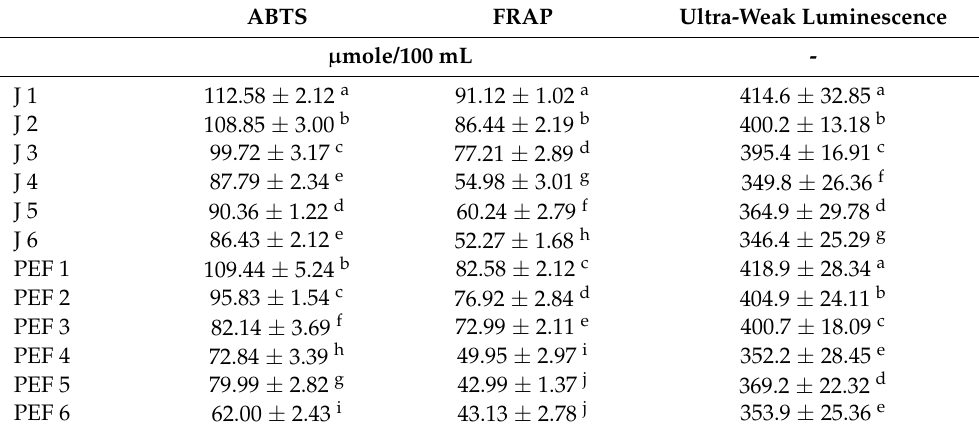
Table 2. Antioxidant activity and ultra-weak luminescence in black chokeberry juice. ABTS FRAP Ultra-Weak Luminescence µ mole/100 mL